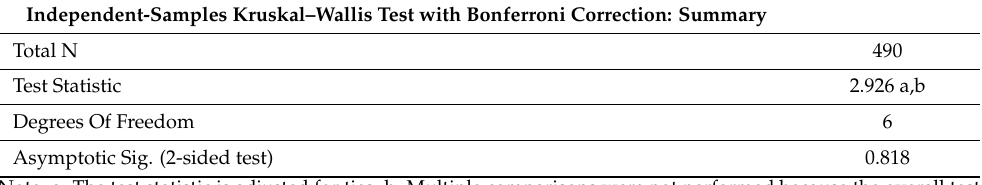
Table A5. Effects on response time (logical thinking abilities).